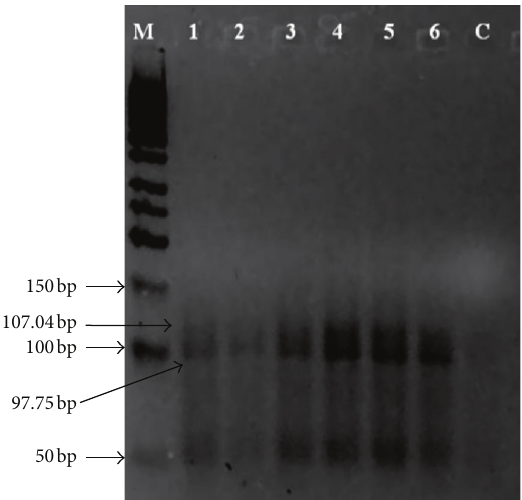
Figure 3: Amplification profile of SSR primer P1T6 (1:AM, 2:FM,